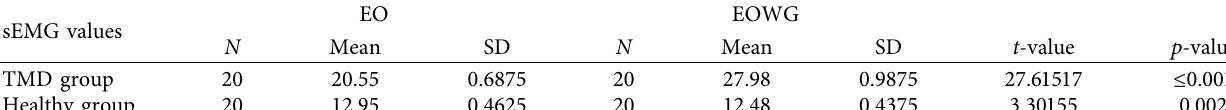
Table 7: EMG values with open eyes with and without glasses.